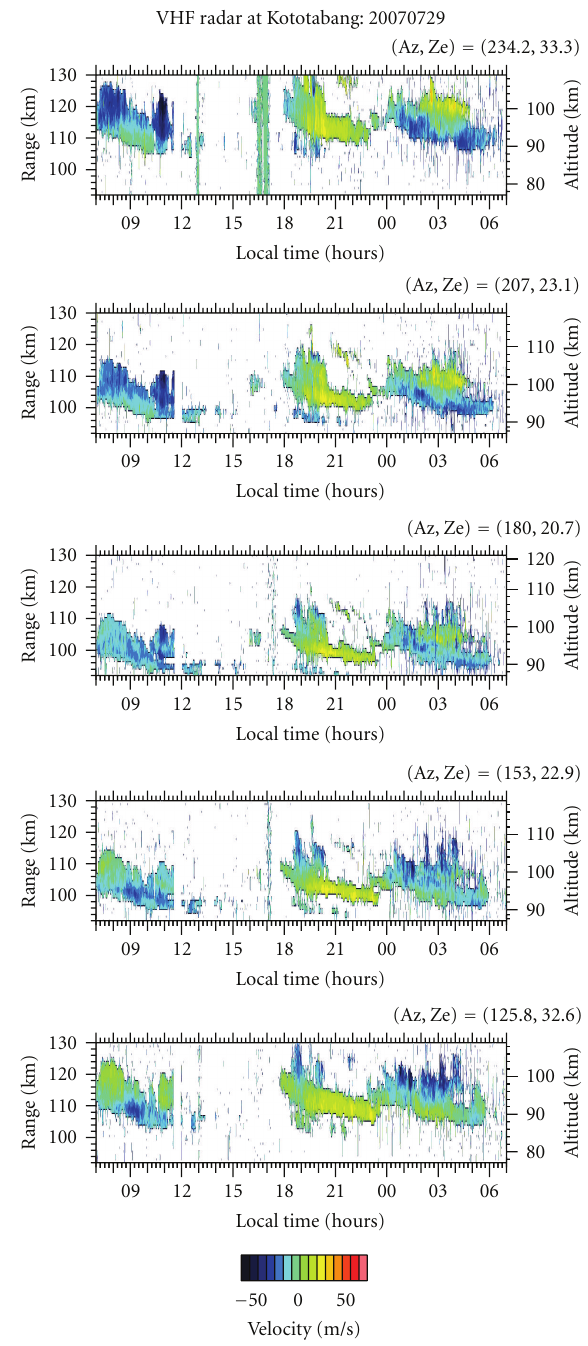
Figure 2: Same as Figure 1, but for line-of-sight Doppler velocities of the E -region FAIs (positive toward the